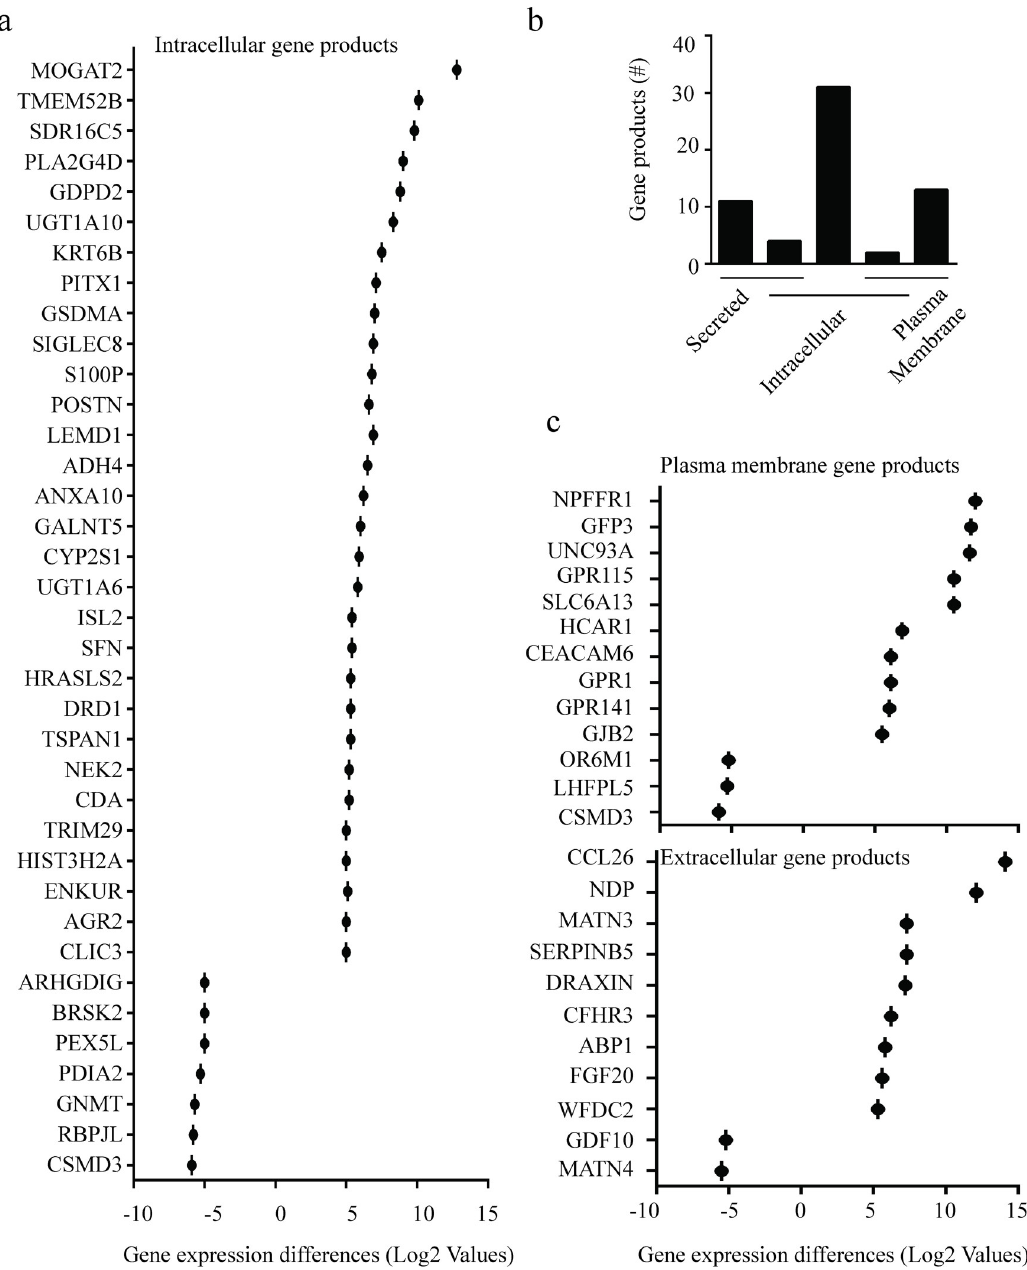
Fig 2. Genes within the high stringency criterion for differential expression between tumor and non-tumor pancreatic tissue and the subcellular localization of theoretical protein products. (a) Log fold differences of genes identified to translate intracellular proteins. (b) Quantity of gene products that were localized to the intercellular, extracellular (secreted), and/or within the plasma membrane. (c) Log fold differences of genes that translate proteins localized to the plasma membrane or extracellular